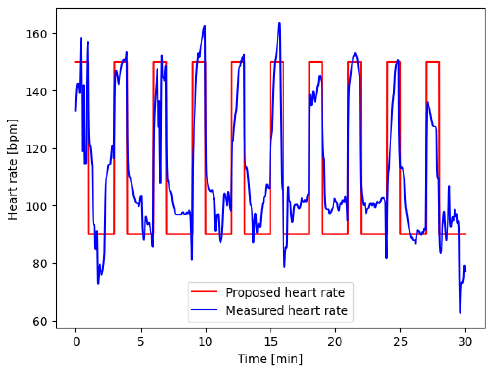
Figure 4. Professional sport